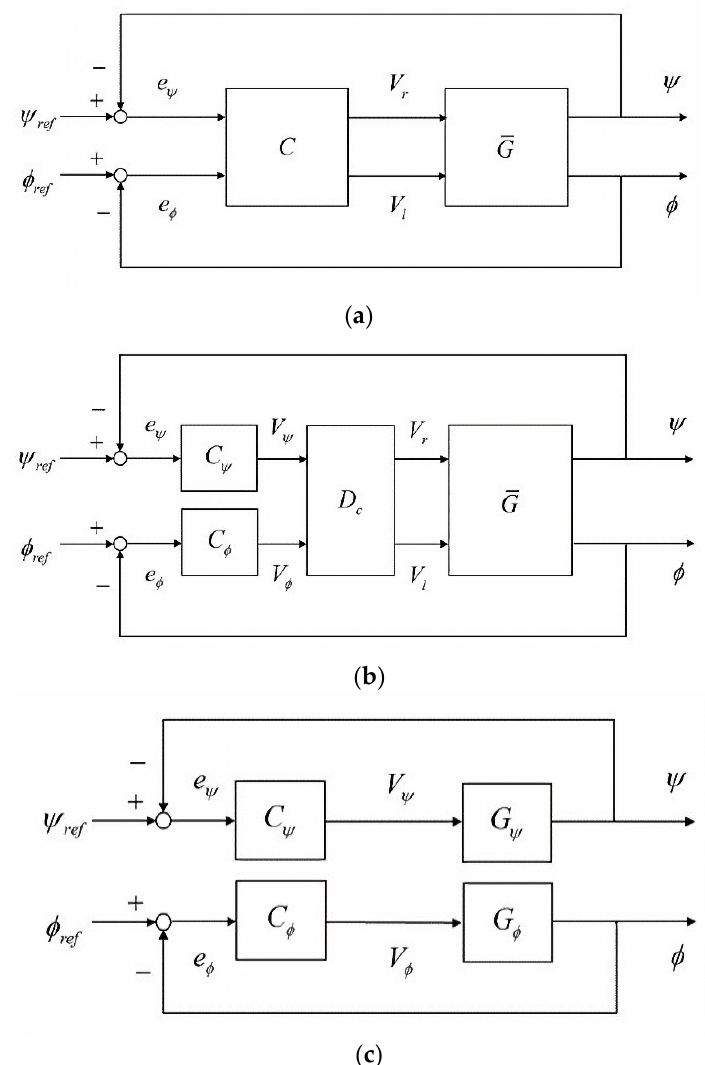
Figure 10. The block diagram of decoupling process: ( a ) The feedback control system of TWIP; ( b ) Block diagram of the TWIP system with decoupling matrix; ( c ) Block diagram of the TWIP system combining decoupling matrix .